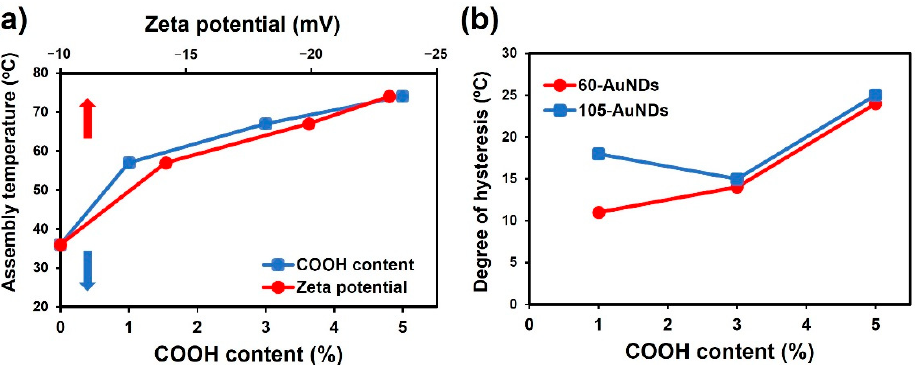
Figure 5. ( a ) Effects of COOH content (blue) and zeta potential (red) on the assembly temperature of 105-AuNDs and ( b ) a plot of the degree of hysteresis against the COOH content for 105- (blue) and 60-AuNDs (red).